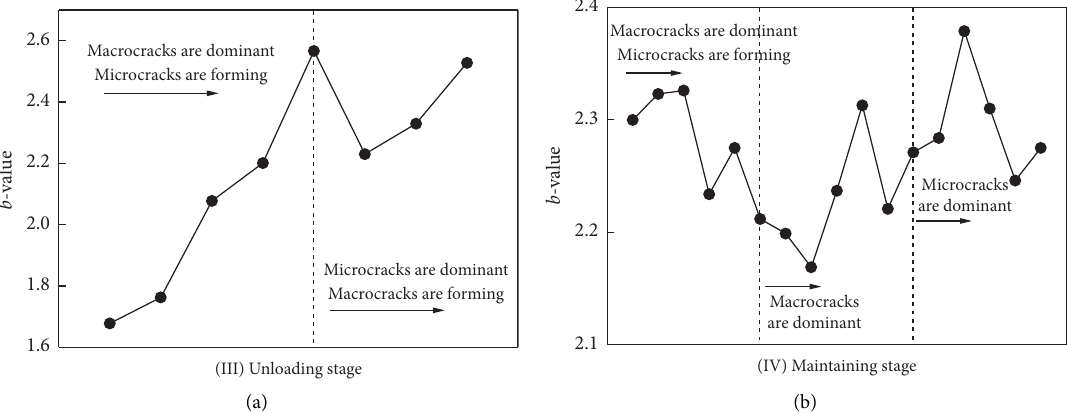
Macrocracks are dominant Microcracks are forming